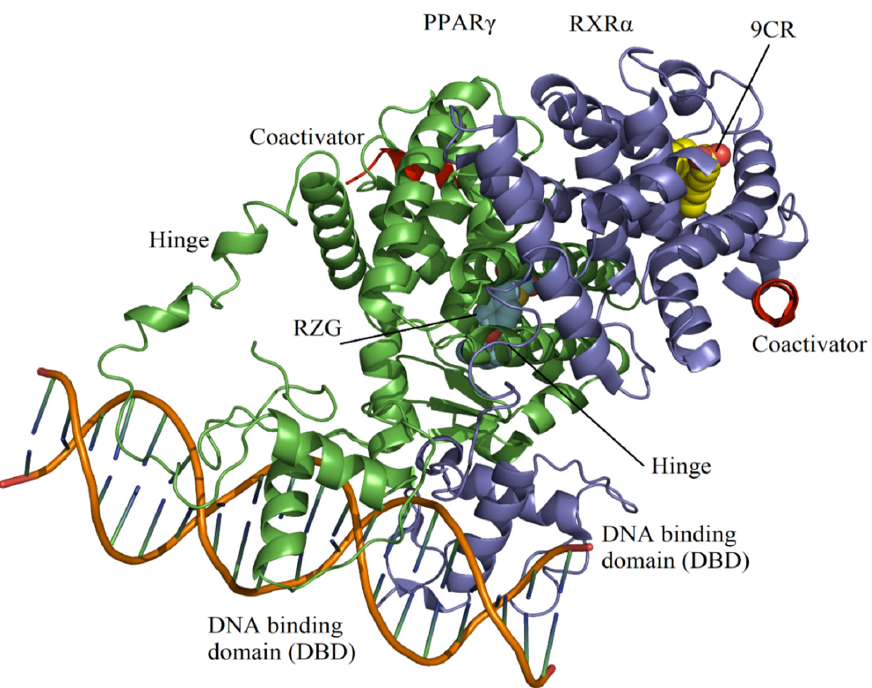
Figure 1. Structural topology of the RXR α -PPAR γ -DNA system (PDB entry 3DZY) [25]. PPAR γ and RXR α are presented in green and purple, respectively. For each receptor, a flexible hinge connects the DBD and the LBD. Figure was built by using PyMOL [26].